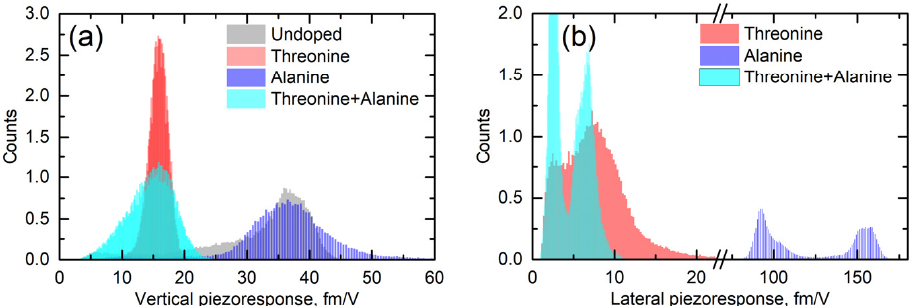
Figure 5. Histograms of ( a ) vertical and ( b ) lateral piezoresponses in α -glycine crystals doped with different molecules (L-alanine, L-threonine, and L-alanine + L-threonine).